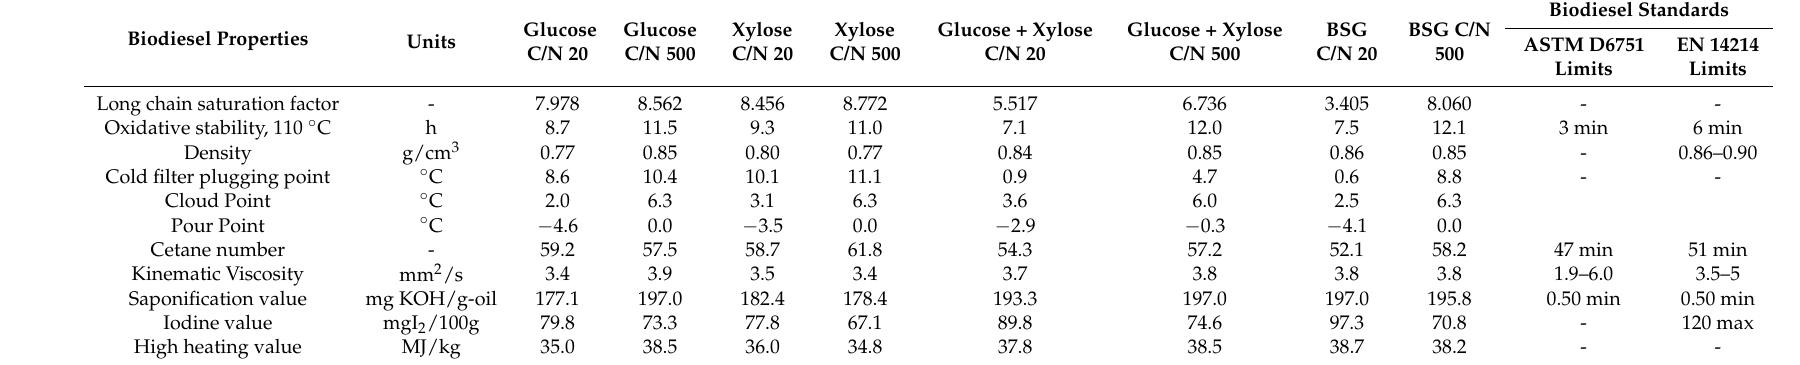
Table 3. Assessment of biodiesel properties by empirical